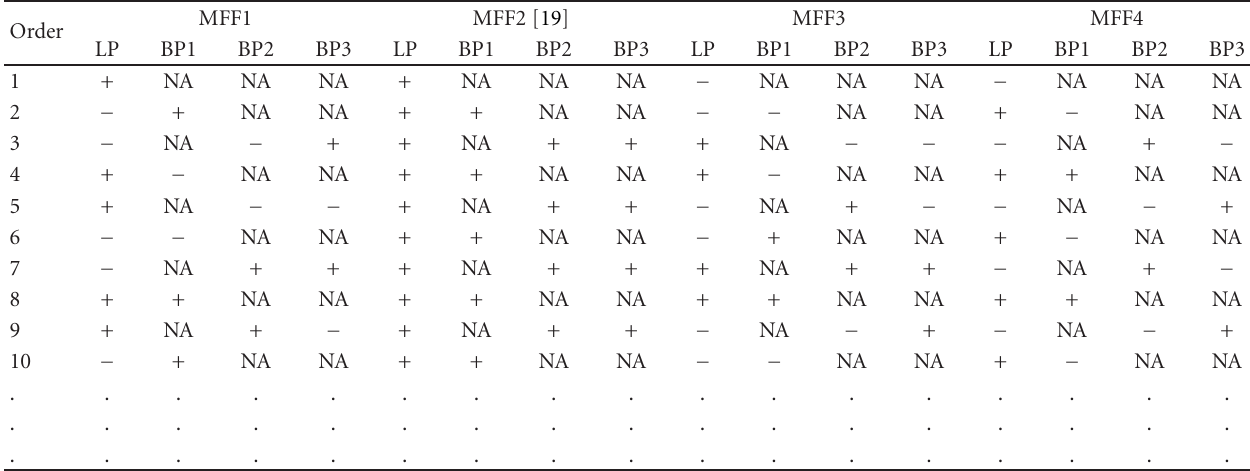
Table 1: Signs (Noninverting or inverting) of the filter functions (NA: Not Applicable, BP1: BP ( n / 2) , BP2: BP ( n +1) / 2 , BP3: BP ( n − 1) / 2) . MFF1 Order